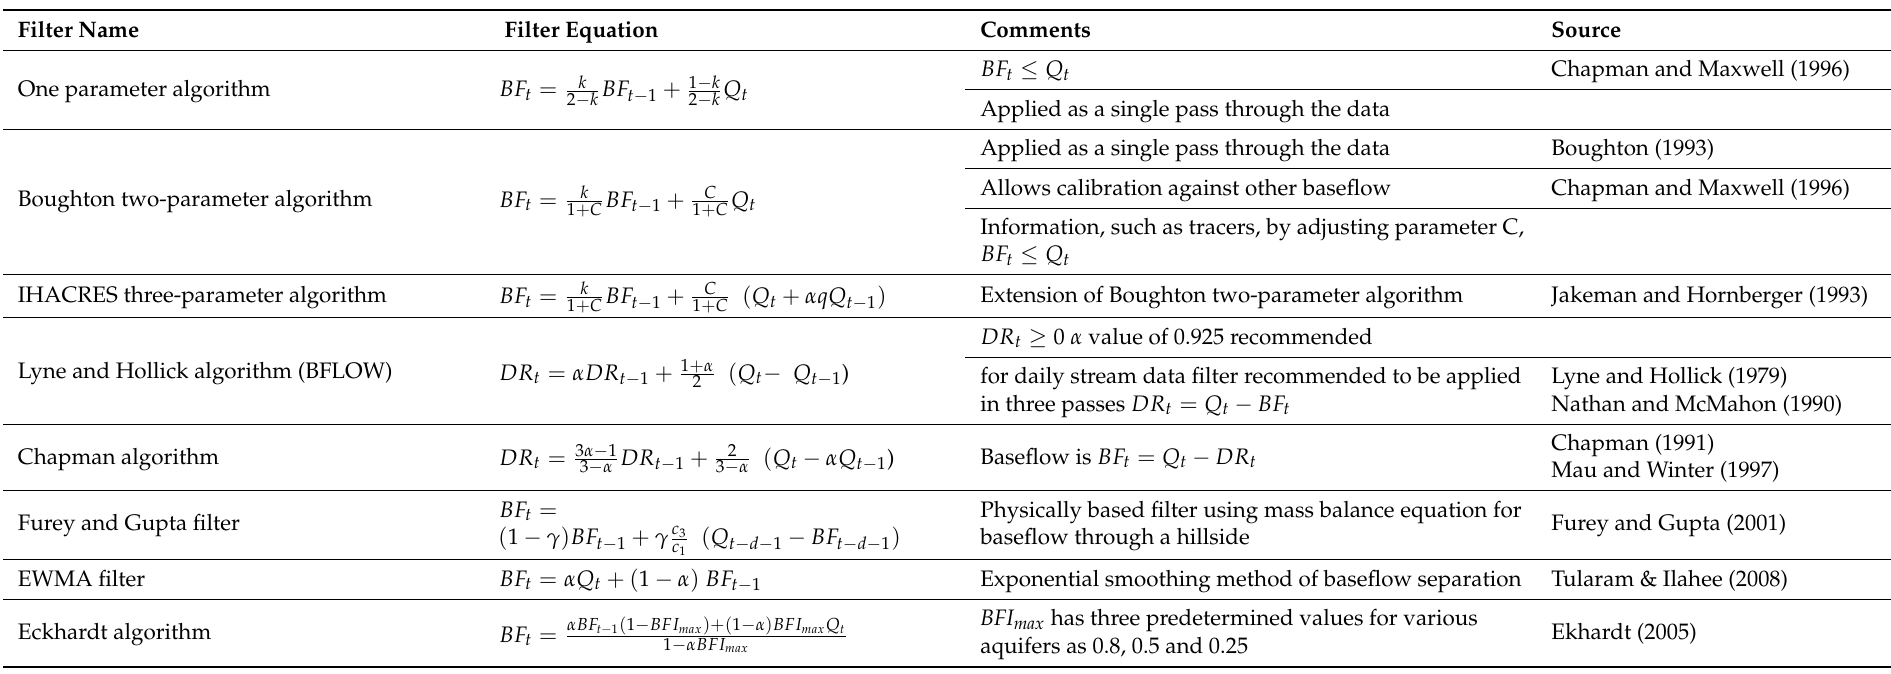
Table 2. Summary of RDF used in BFI+ Program modified from